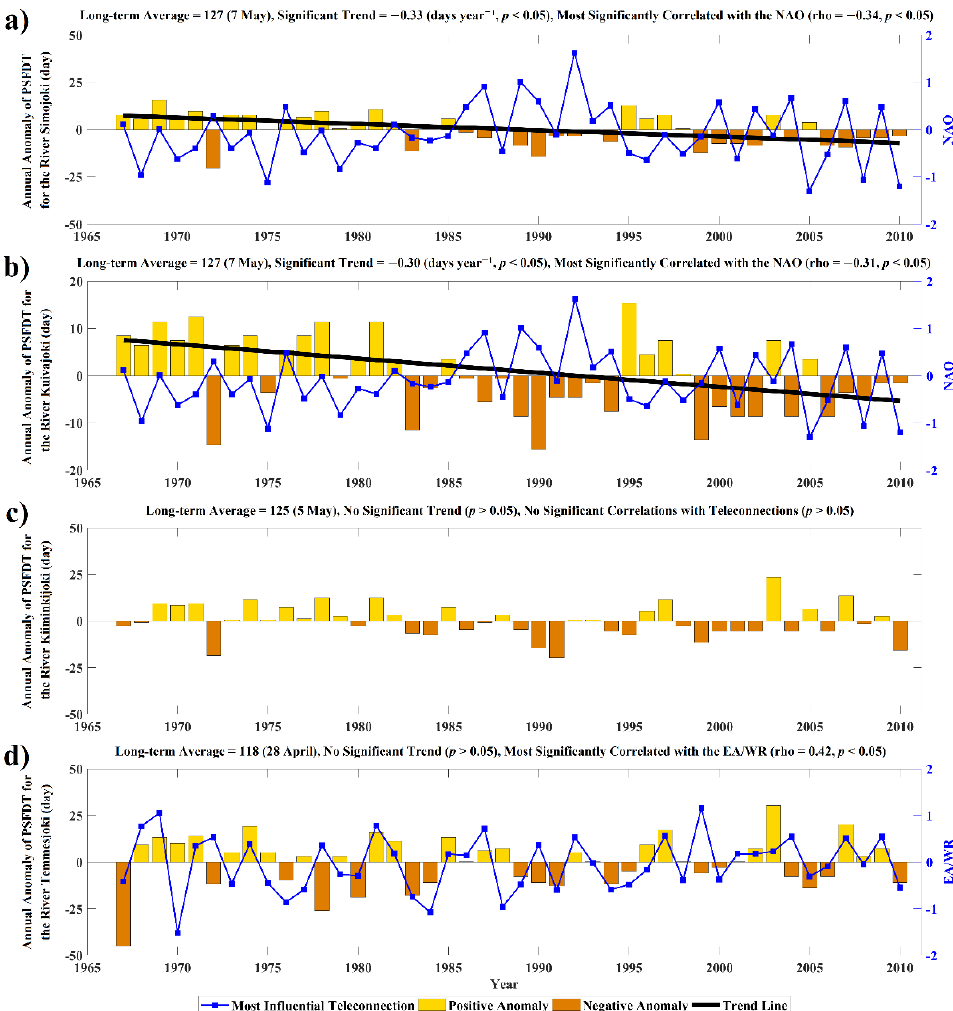
Figure 3. Annual Anomalies with significant trend line ( p < 0.05) and the most influential springtime climate teleconnection for peak spring flood discharge timing (PSFDT) in the ( a ) Simojoki, ( b ) Kuivajoki, ( c ) Kiiminkijoki, and ( d ) Temmesjoki rivers across northern Finland during 1967 – 2011.